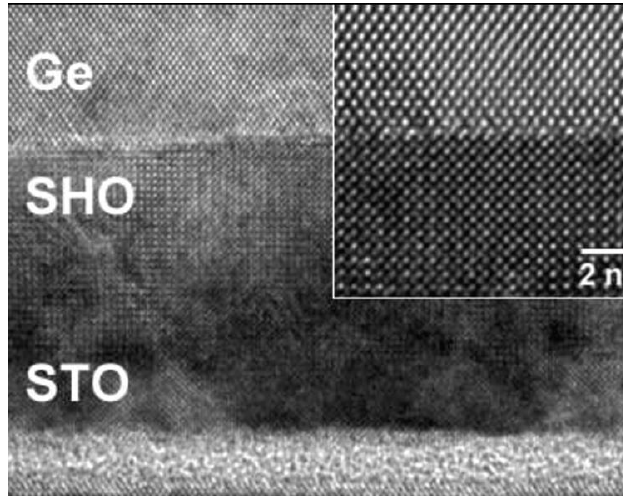
Figure 4. HRTEM image of Ge grown on SHO. The interface between Ge and SHO is atomically sharp and contains no interfacial layer (inset), reprinted with permission from [46]. Copyright 2007,